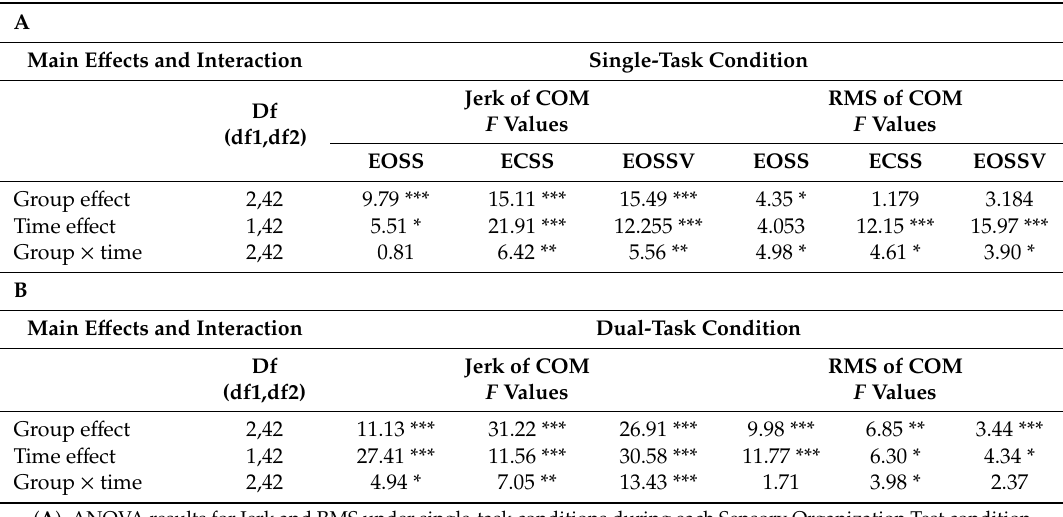
Table 4. Jerk and RMS of COM results under single- and dual-task conditions for each Sensory Organization Test